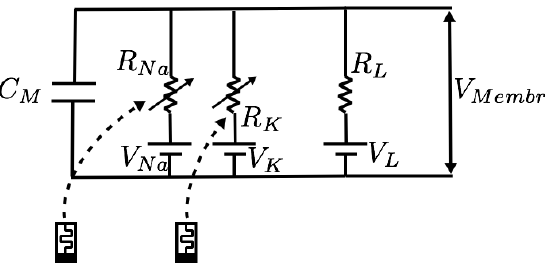
Figure 10. The Hodgkin–Huxley model, with the variable resistances of the Sodium and Potassium channels interpreted as